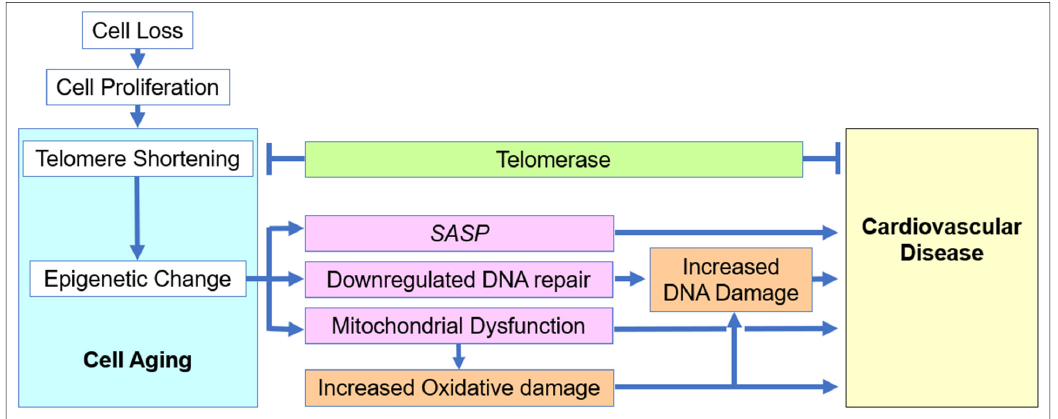
Figure 3. The cascade of pathology in age-related cardiovascular disease. During aging, cell divi- sions lead to telomere shortening upon TERT inactivation. This results in the global alteration of gene expression. Combined with the subsequent damage accumulation in DNA and other cell com- ponents, this process leads to cell senescence and SASP, which ultimately accounts for cell and tissue dysfunction. Telomerase, being a pivotal link in the process, is a potentially effective point of inter- vention.